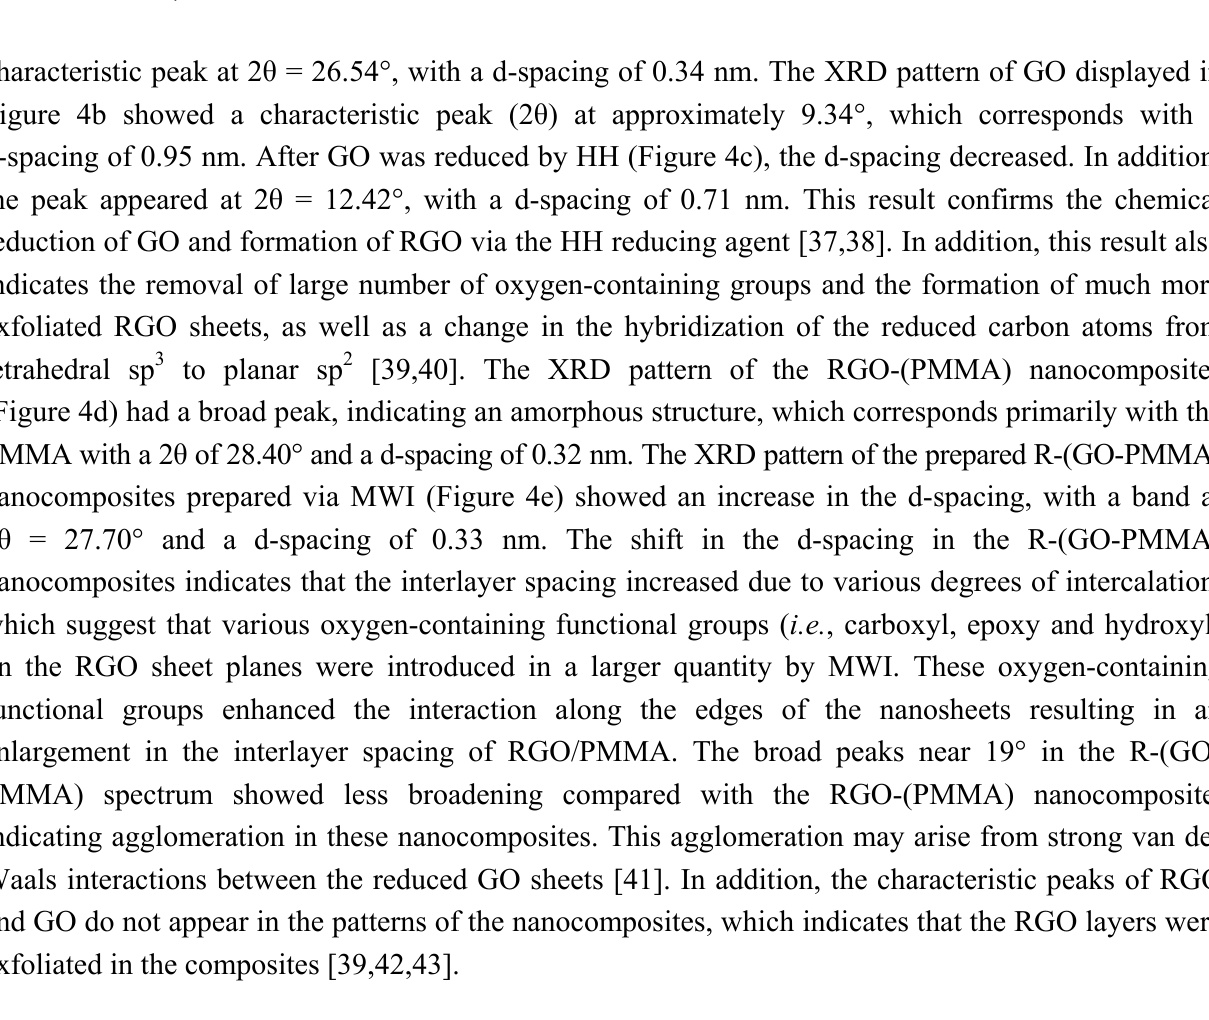
Figure 4. XRD patterns of ( a ) Graphite; ( b ) GO; ( c ) RGO; ( d )